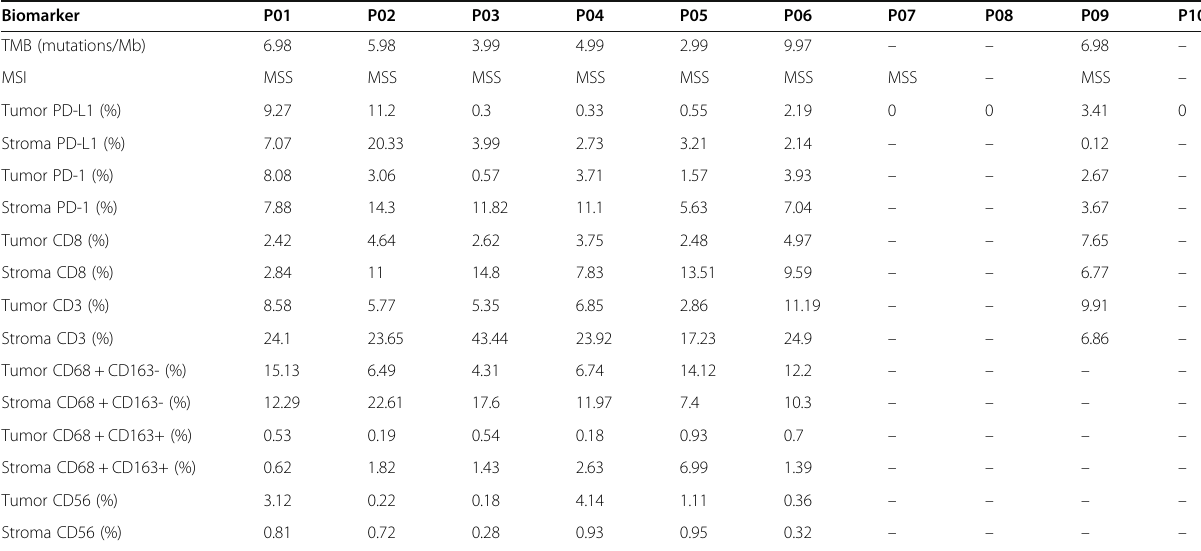
Table 3 Tumor mutational burden, microsatellite stability status, and multiplex immunohistochemical predictive biomarkers Biomarker